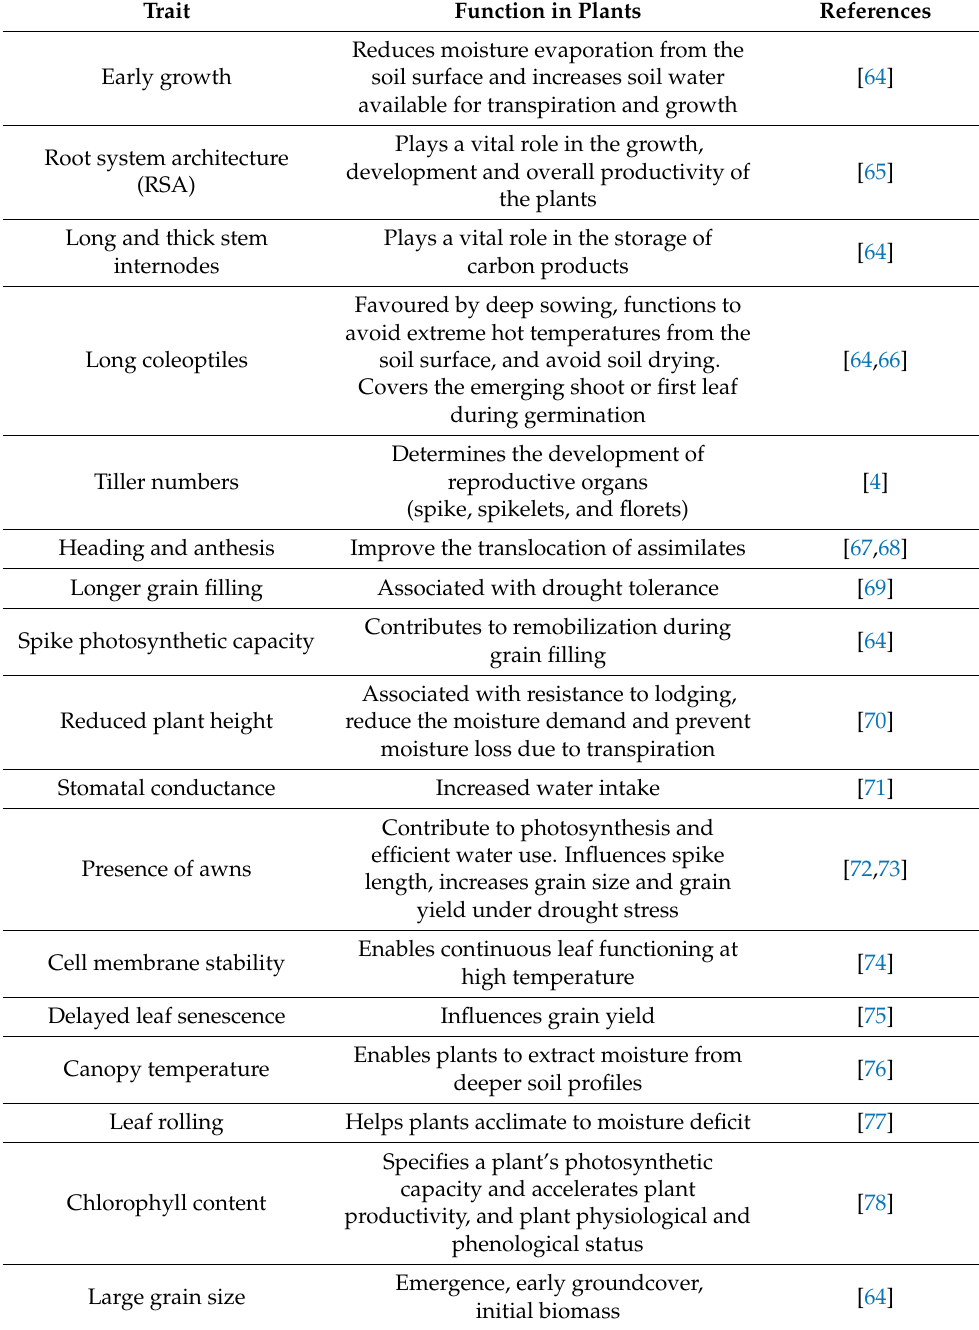
Table 2. Agro-morphological traits responsive to drought stress in